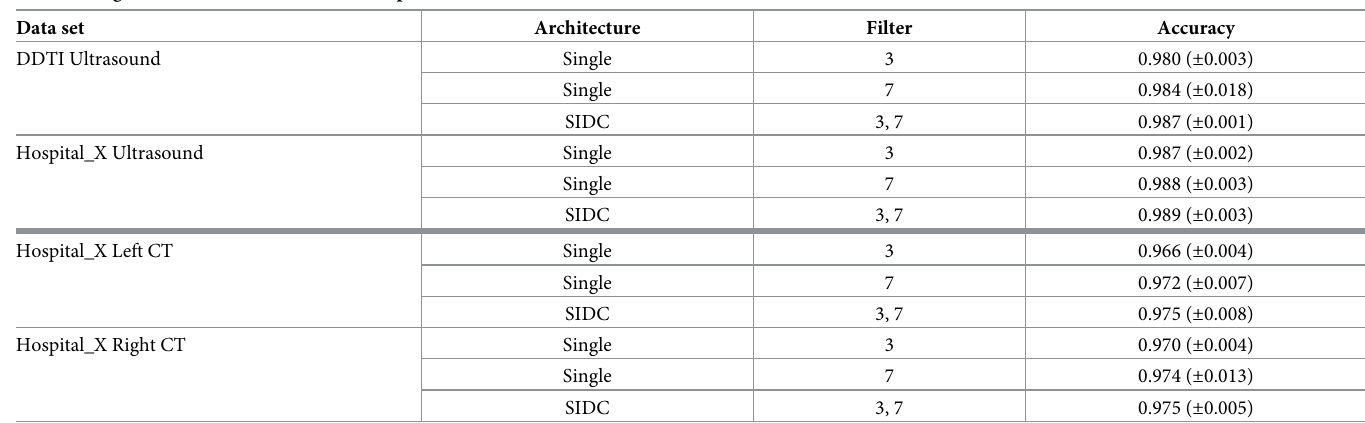
Table 4. Single-channel and dual-channel comparison.